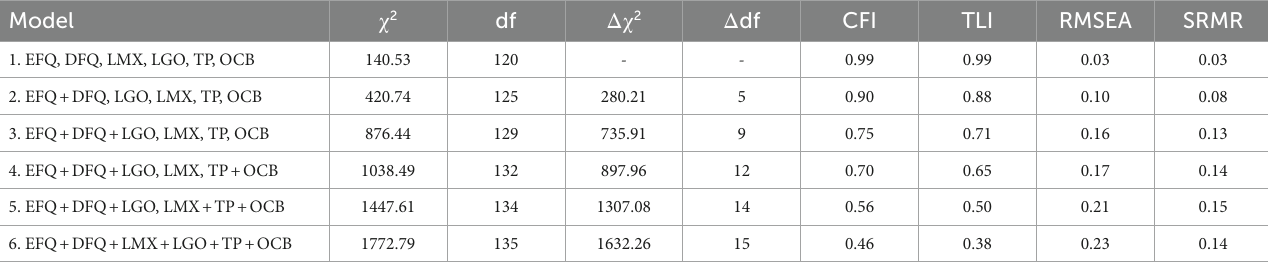
TABLE 2 Confirmatory factor analyses